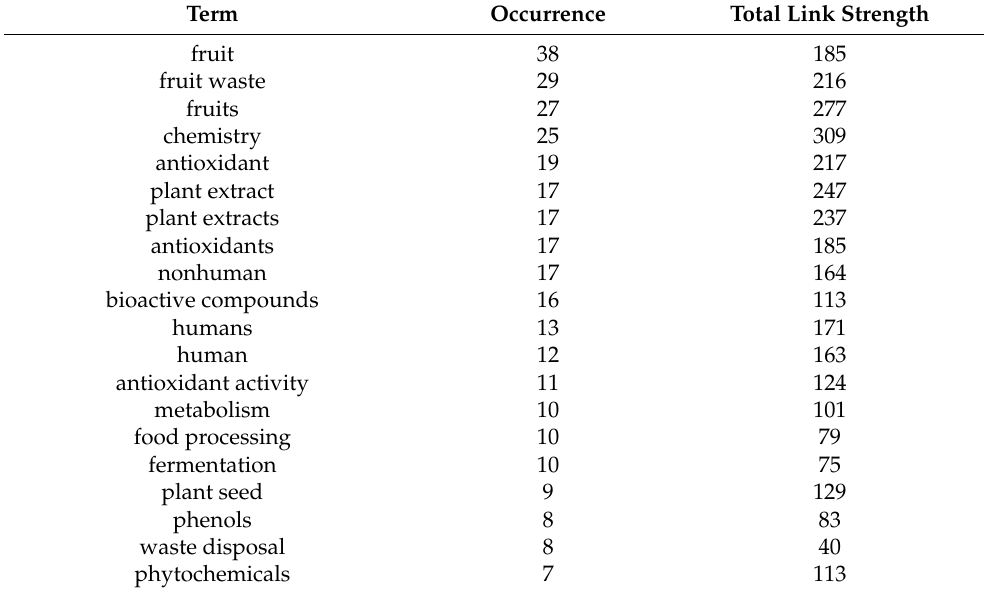
Figure 6. Term map for fruit waste/by-product and health research. Bubble size represents the number of publications. Bubble color represents the citations per publication (CPP). Two bubbles are closer to each other if the terms co-appeared more frequently (Bibliometric data were extracted from the Scopus online database and elaborated by VOSviewer software). Table 1. The top-recurring terms for fruit waste/by-product and health search (Bibliometric data were extracted from the Scopus online database and elaborated by VOSviewer